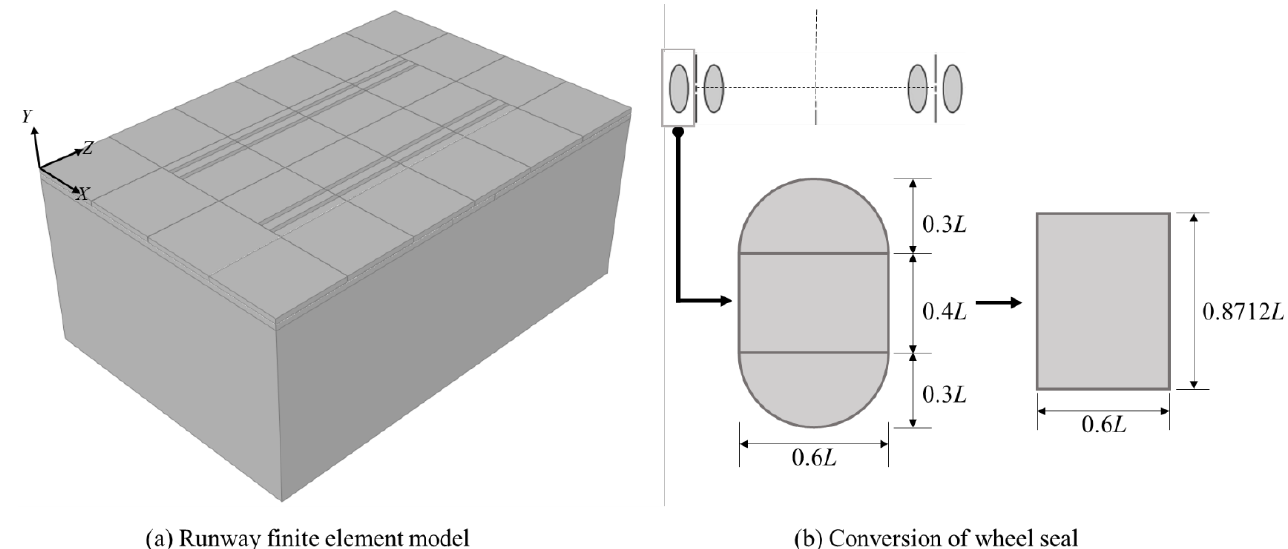
Figure 6. Finite element model of runway and loading wheel print.